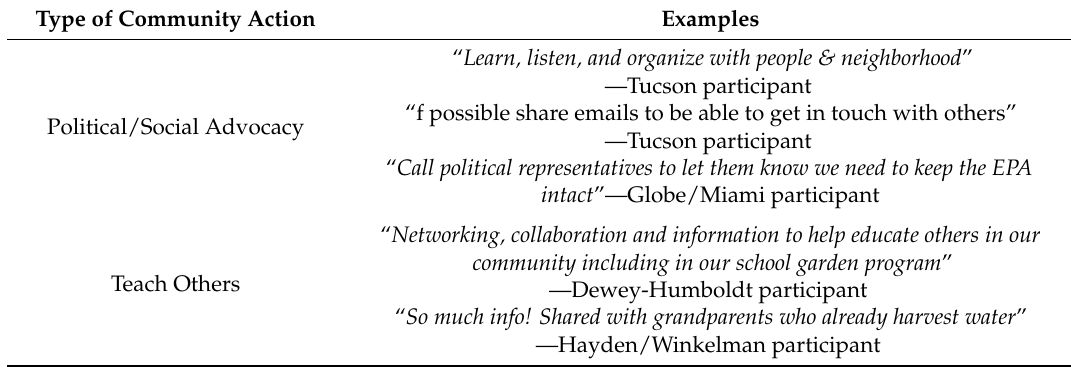
Table 8. Participant survey responses related to community